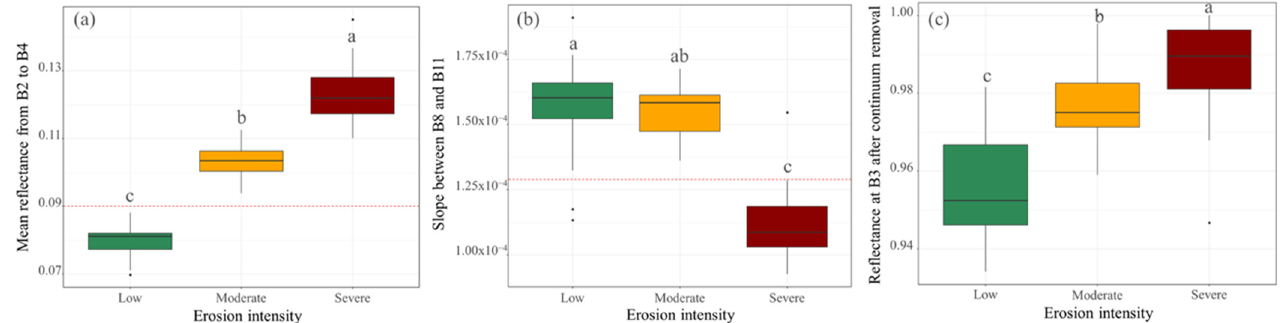
Figure 8. Boxplots of Sentinel-2 spectral indices used for spectral separation of erosion intensity classes. ( a ) Mean reflectance over the three visible bands (B2, B3, B4), ( b ) slope between B8 and B11, and ( c ) continuum-removed reflectance value at 670 nm. Different letters indicate significant differ- ences among the three groups ( p < 0.05).